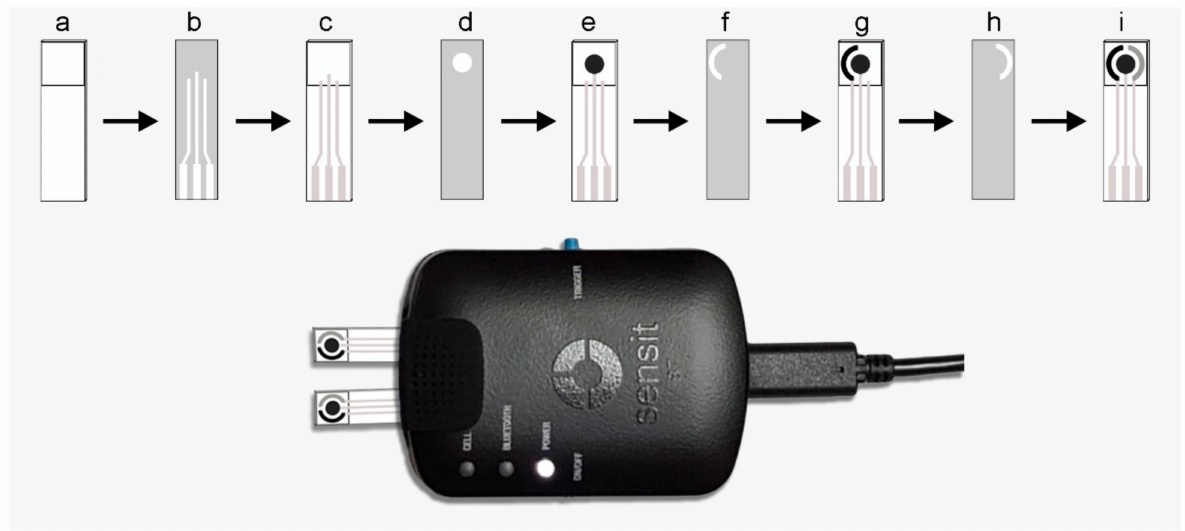
Figure 1. Schematic for the fabrication protocol of the paper-based impedance sensor and the measurement device with the sensors installed, where: ( a ) is the paper strip cut into appropriate size and paraffin-impregnated within defined test area; ( b ) is the mask 1 for the connecting wires and connectivity pads; ( c ) is the screen-printed connectivity pads and lead wires using the silver conductive paste; ( d ) is the mask 2 for the working electrode; ( e ) is the screen-printed working electrode using the high conductivity graphene/carbon hybrid ink; ( f ) is the mask 3 for the counter electrode; ( g ) is the screen-printed counter electrode with carbon ink; ( h ) is the mask 4 for the reference electrode; and ( i ) is the screen-printed reference electrode using the Ag/AgCl